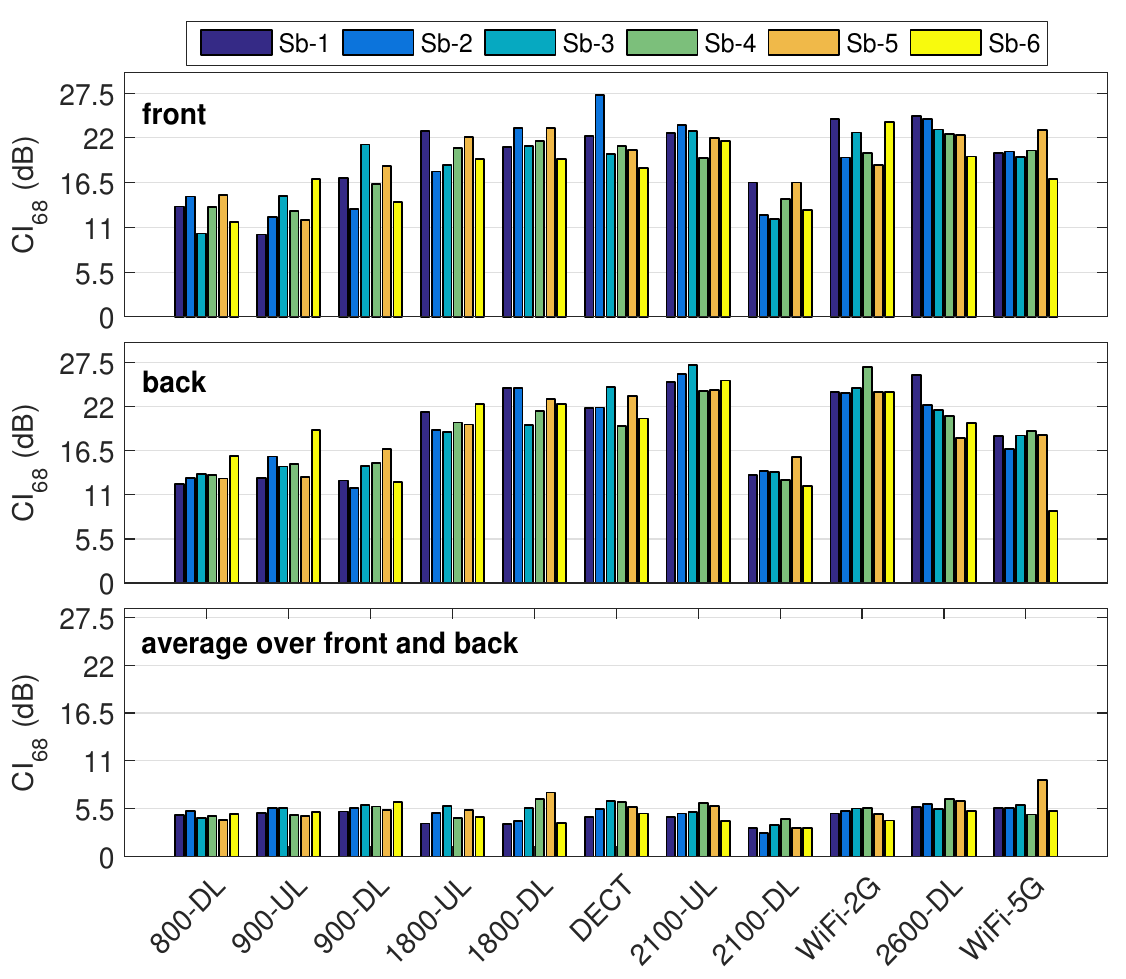
Figure 7. Median 68% confidence interval of the on-body antenna aperture for each person per frequency